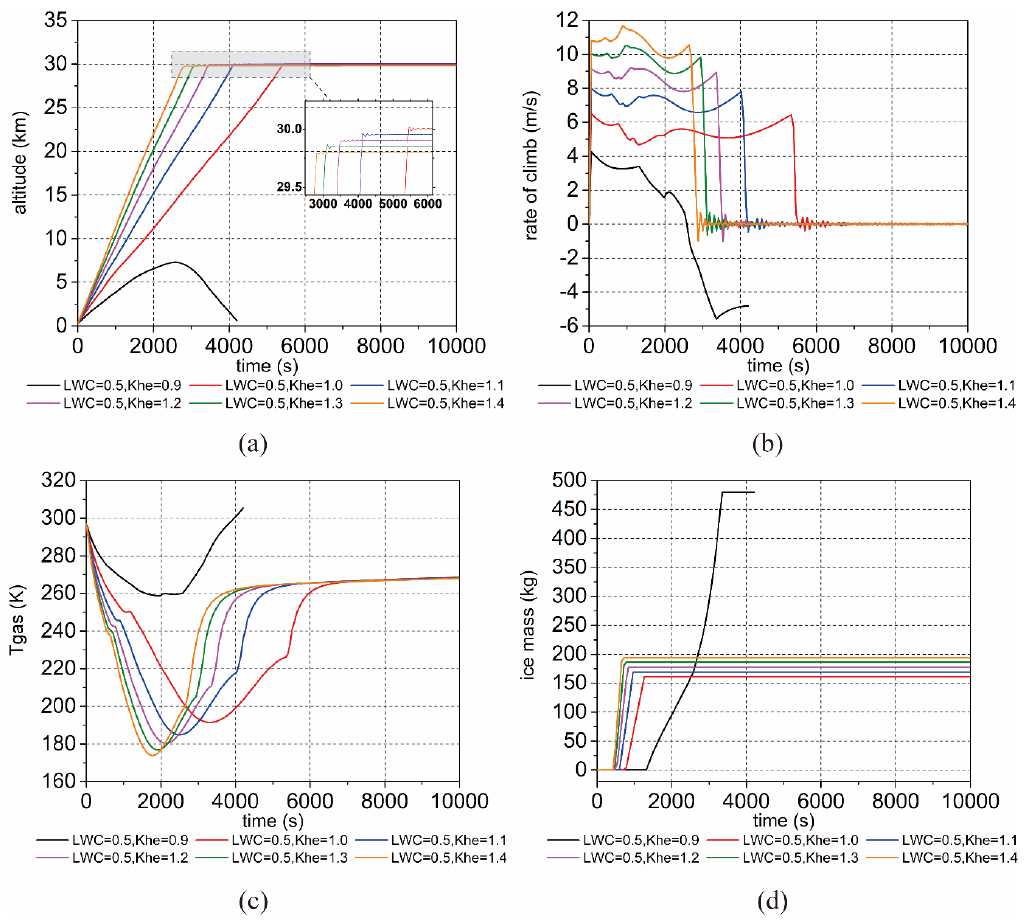
Figure 9. Ascent performance of ( a ) altitude, ( b ) velocity, ( c ) helium temperature, and ( d ) ice mass with different helium masses.